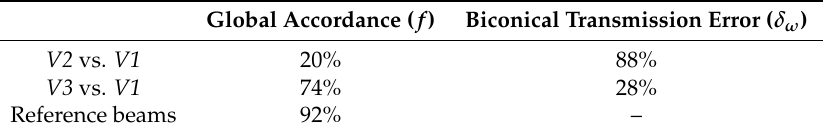
Table 5. Overview significant results: global accordance f V 2, V 1 and biconical transmission δ ω , V 2, V 1 for θ i = 35 ◦ show significant differences between the BSDF of the design geometry and the production sample. The results are better for the comparison of the production sample ( V1 ) with the model ( V3 ) that includes the observed small geometric deviations. The result from the comparison of the virtual and physical reference beams shows the maximal level of global accordance.